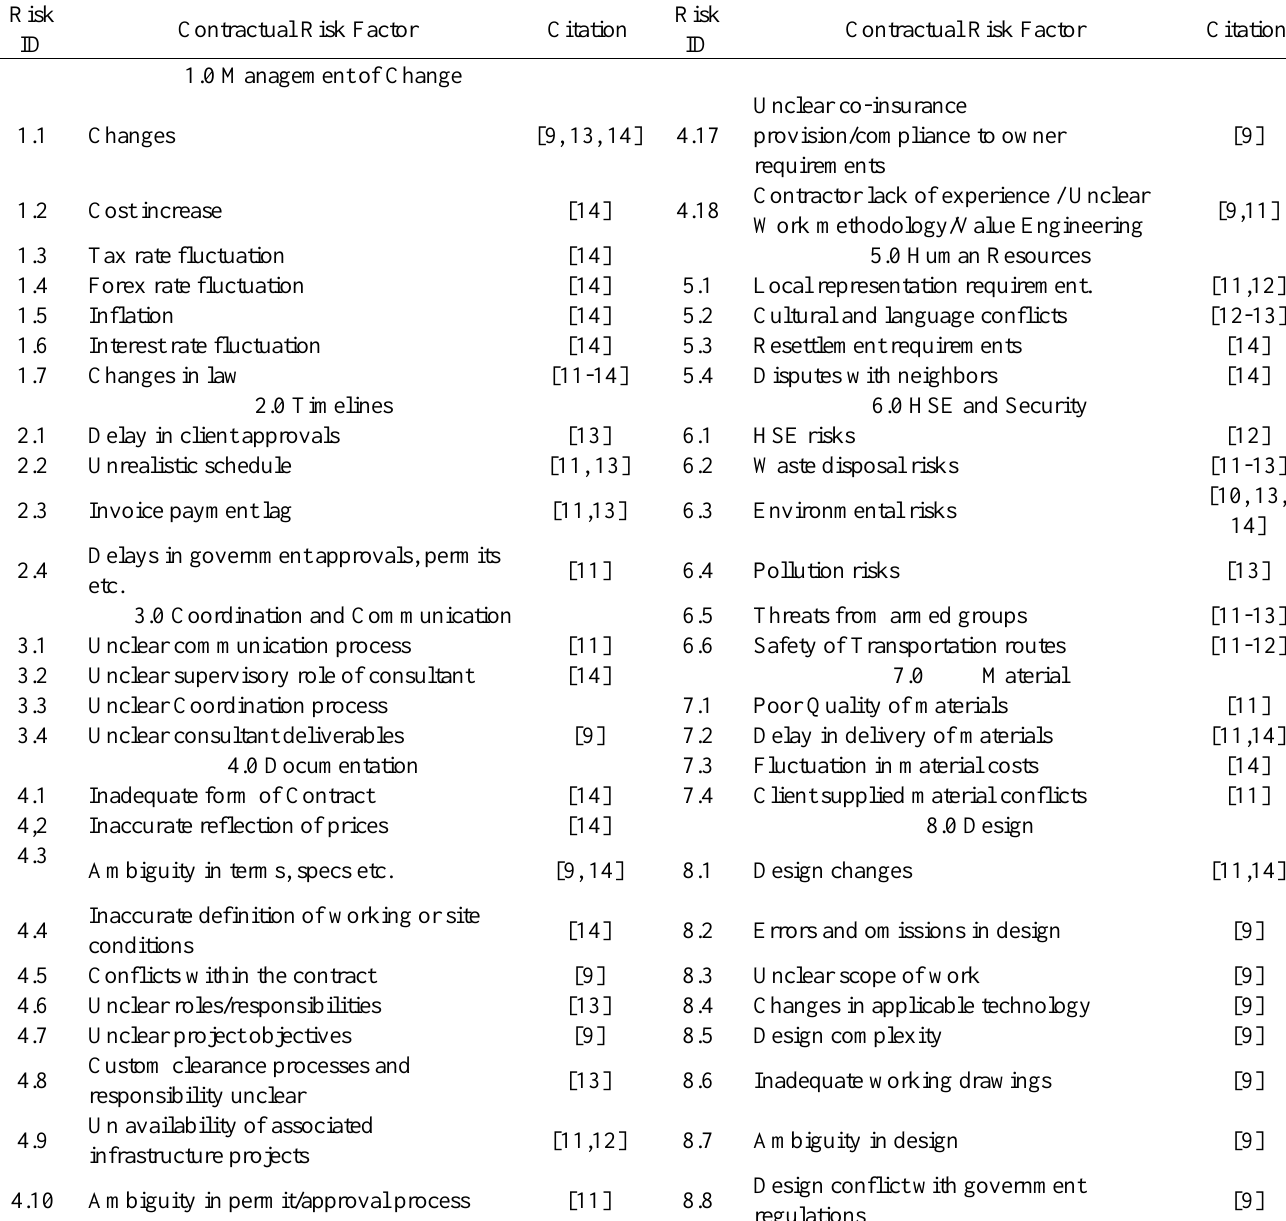
Contractual risk factors in oil and gas sector infrastructure